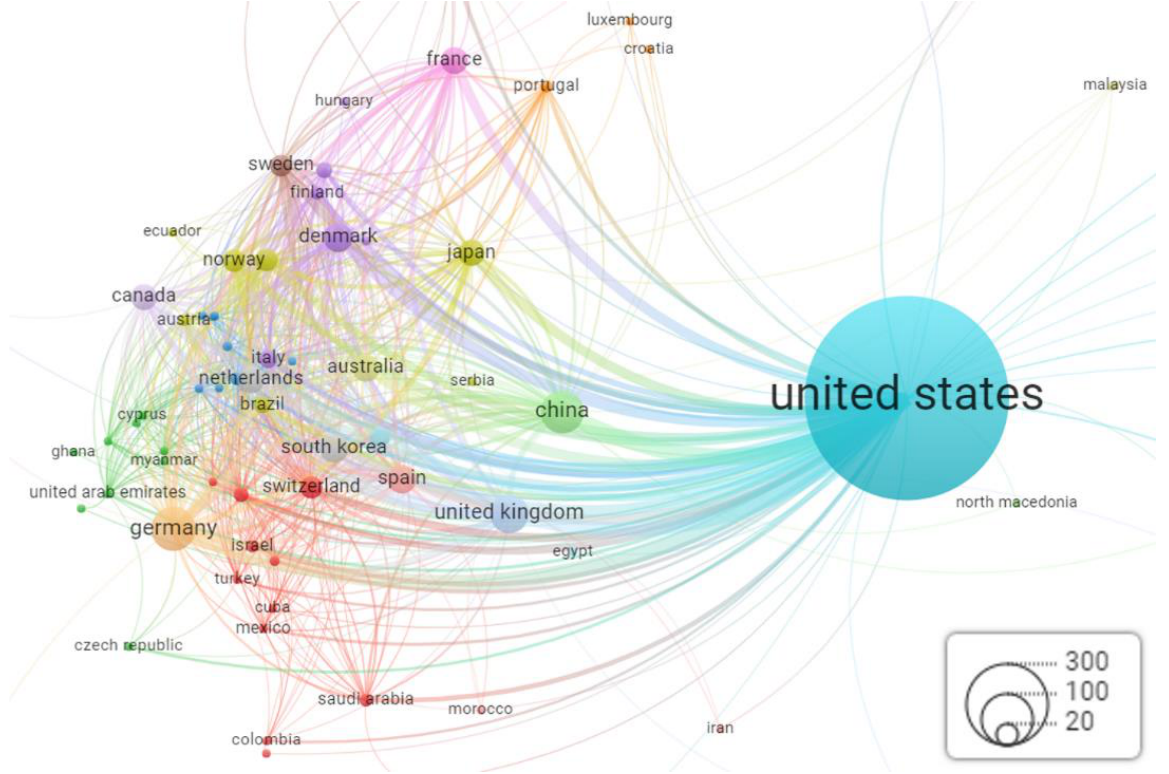
Figure 4. The NREL’s collaboration network. The size of the nodes and the width of the edges represent the number of publications of a country and the co-authored ones, respectively.